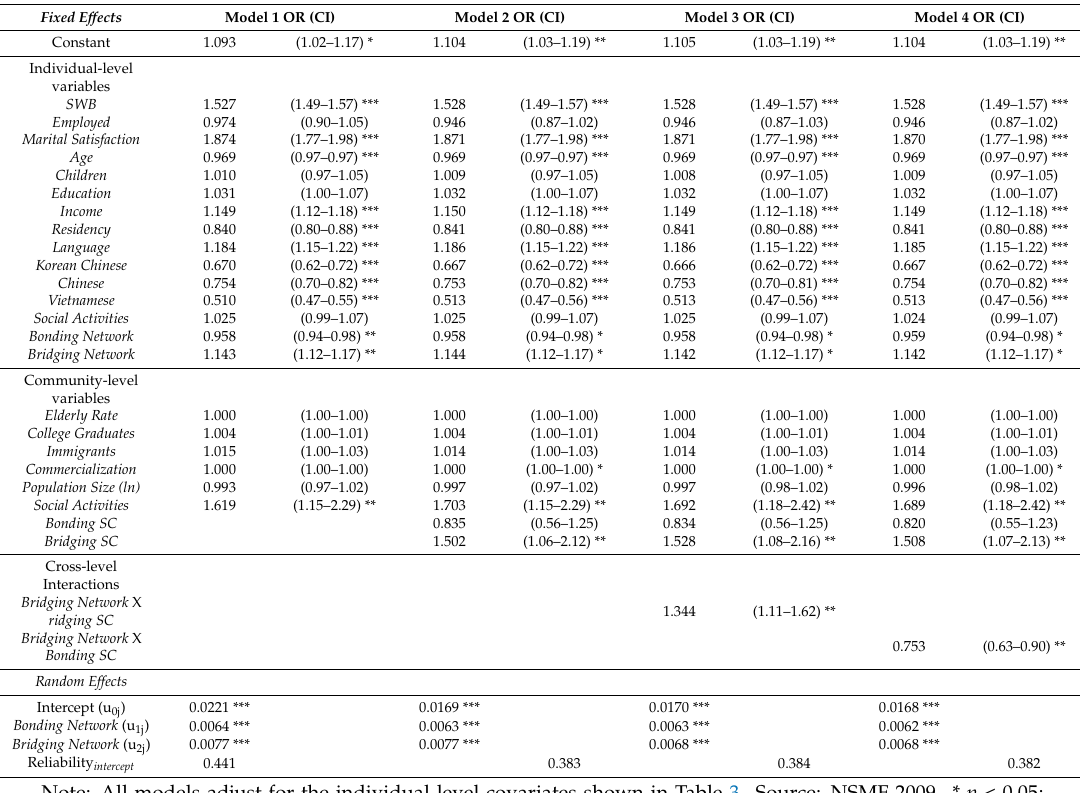
Table 4. Multilevel models of the associations between SRH and social capital measures (Individual- and contextual-level